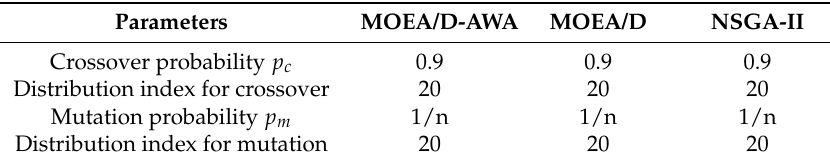
Table 2. Parameters for MOEA/D-AWA, MOEA/D and NSGA-II